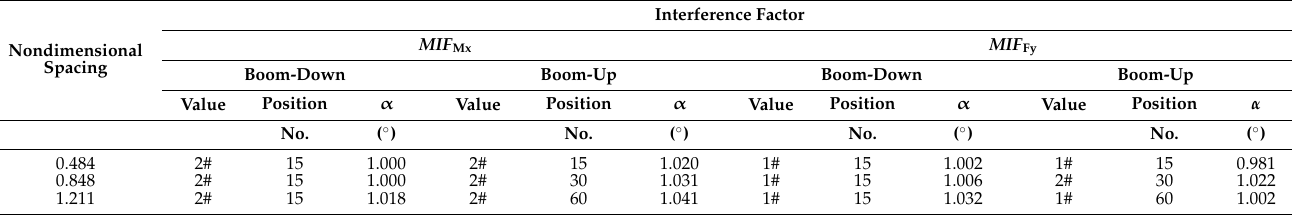
Figure 14. MIF Fy of boom-up cranes. Table 5. Maximum MIF with different